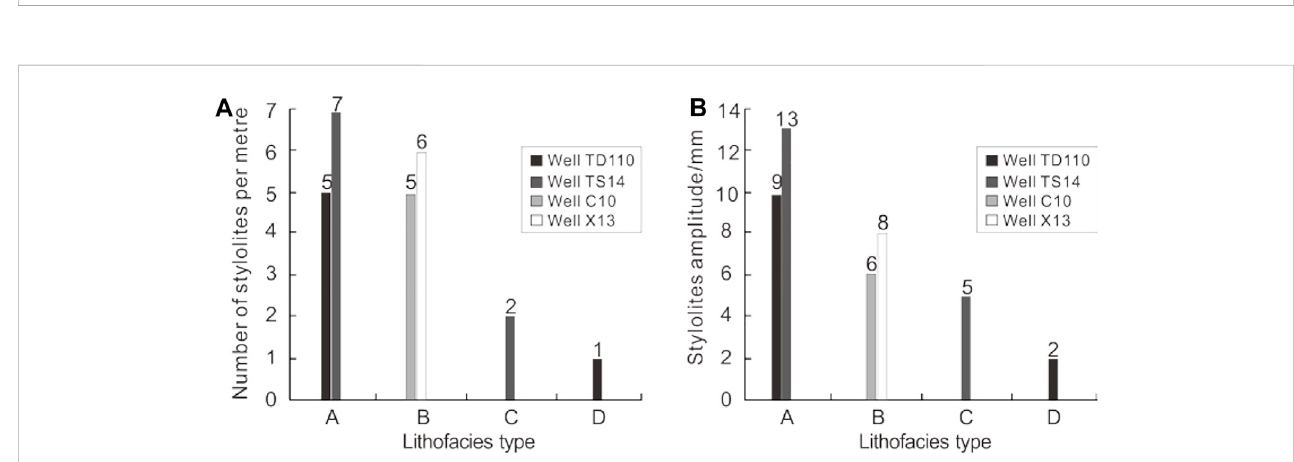
FIGURE 10 Histograms showing frequency (A) and amplitude (B) of the stylolites in different lithofacies of Feixianguan Formation tight oolitic reservoir.